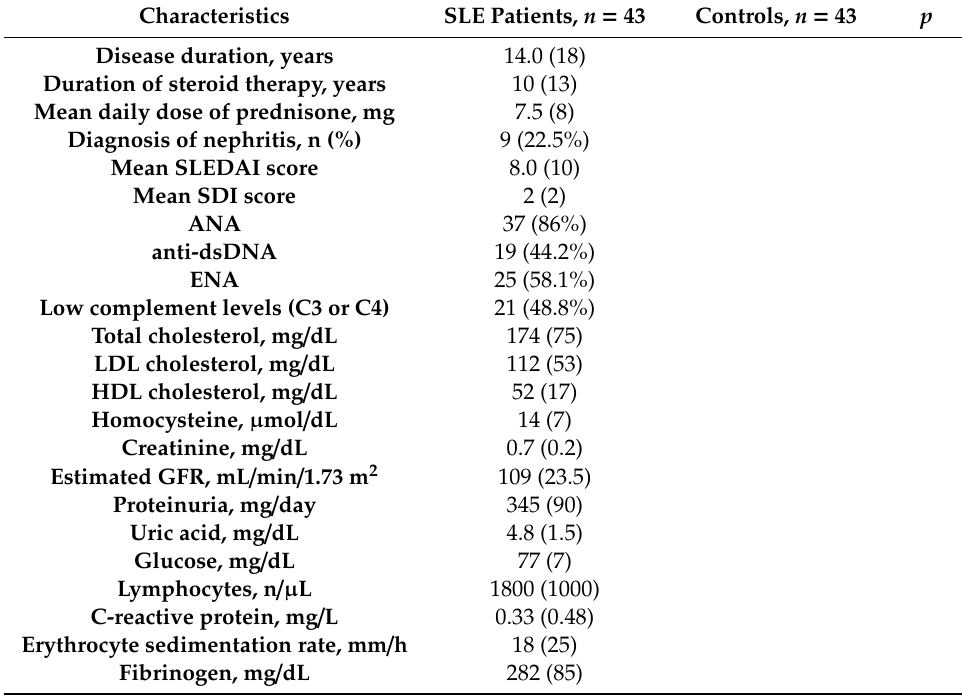
Table 2. Characteristics of SLE (systemic lupus erythematosus) and controls